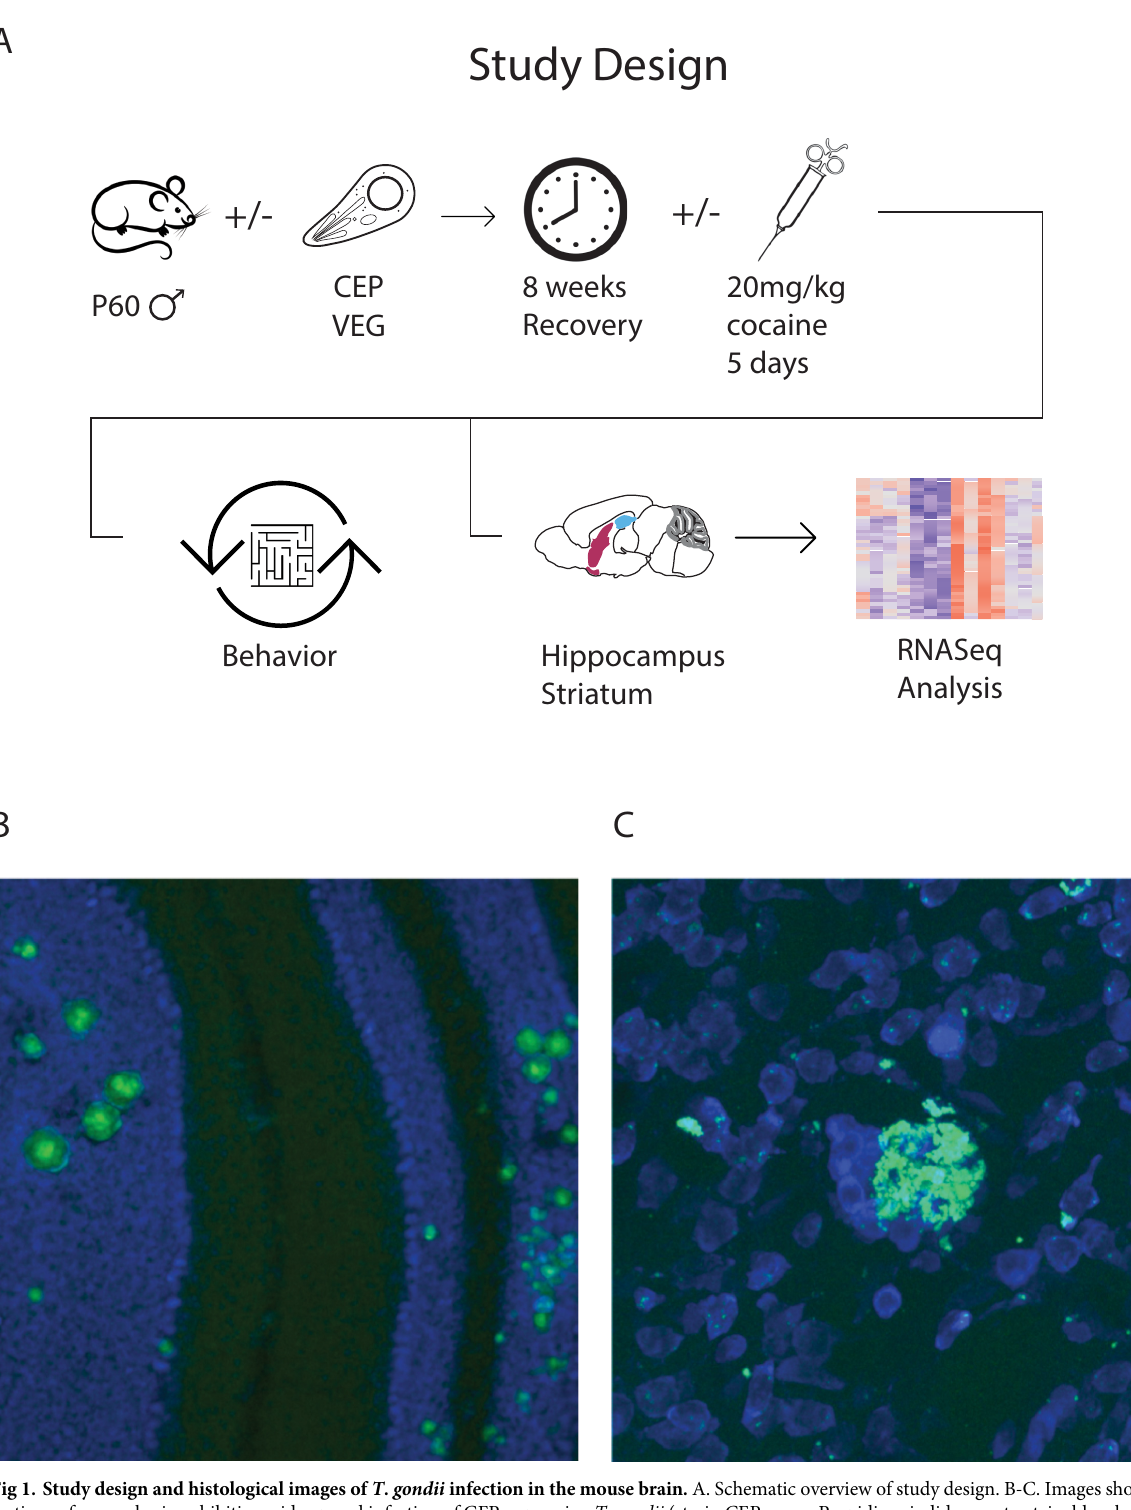
PLOS NeglectedTropical Diseases | https://doi.org/10.1371/journal.pntd.0010600 July 20,